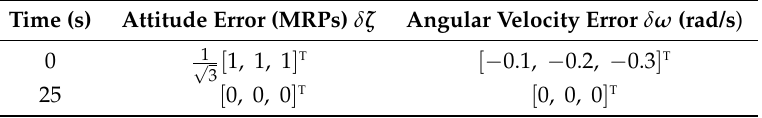
Table 4. Initial/boundary conditions.